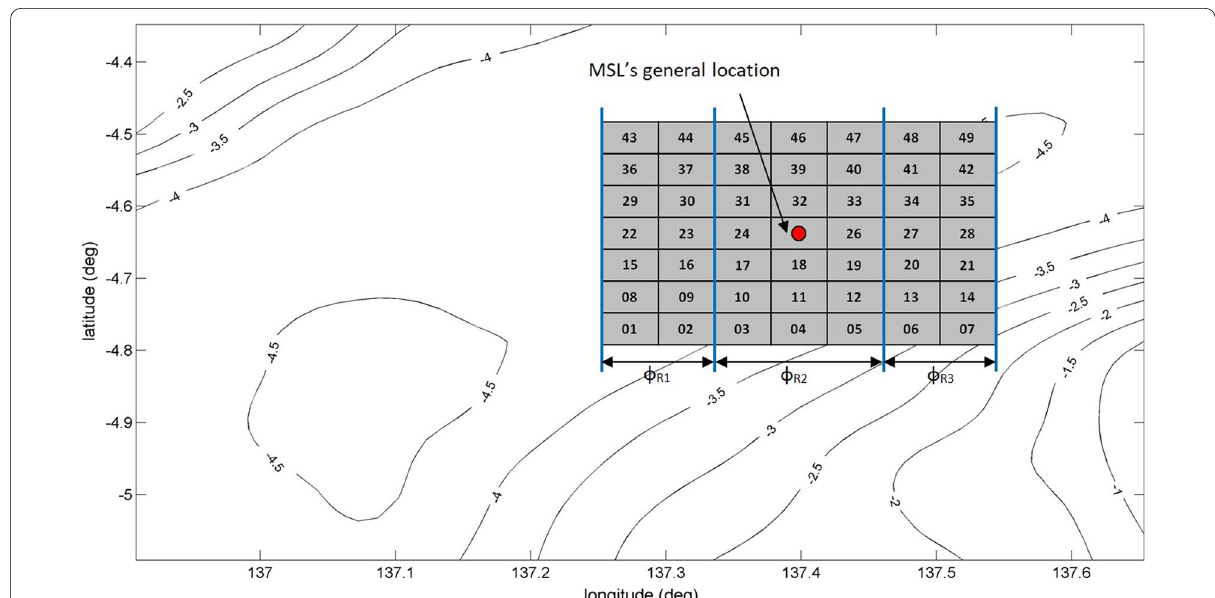
Fig. 6 Spatial domain of the simulations, including the set of simulated source locations. The emission area is represented in gray squares for each simulated location. Methane emission flux is uniformly distributed in the emission area, which covers nine elements of the grid. Isolines depict the ground altitude in kilometers. The MSL’s general location is highlighted by a red dot. Each emission location is labeled by a number. Locations within φ 0.05º, where φ is the longitude of the MSL (~ 137.4°), are enveloped in ф R 2 . Western locations to φ ‑0.05º are enveloped in ф R 1 and eastern ones ± to φ 0.05° in ф R +